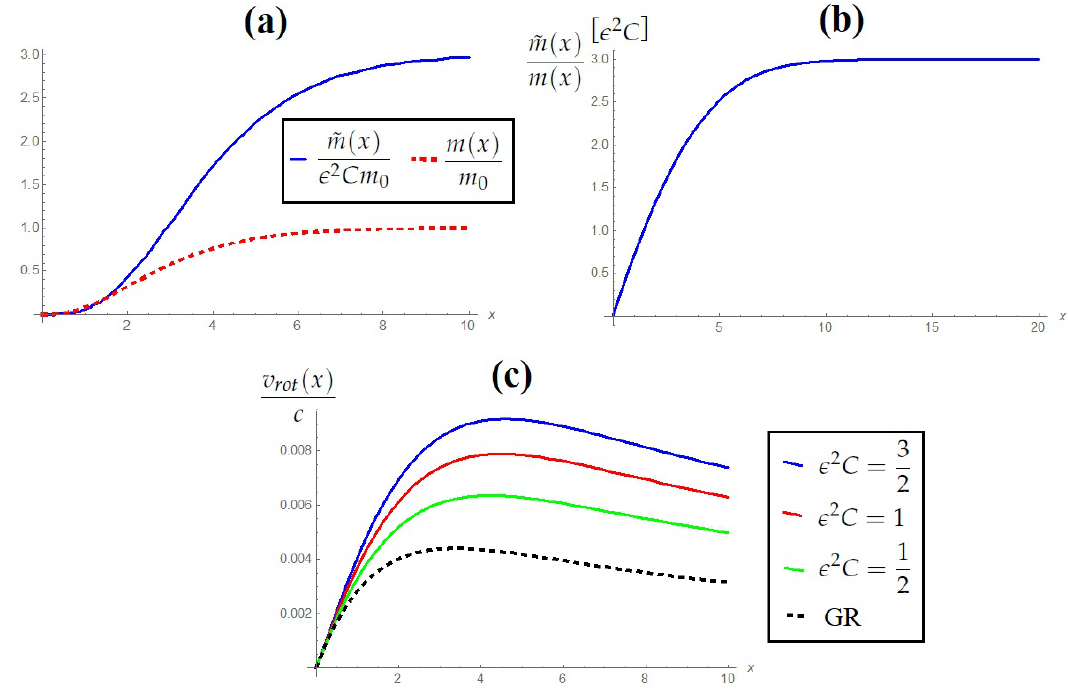
Figure 2. Exponential Profile Calculation. ( a ) ordinary and δ Matter vs. normalized radius, with m 0 = 8 π R 3 ρ 0 . From the center, more δ Matter is accumulated, but the behavior of both terms ( x ) become similar when we distance from the center; ( b ) ˜ m (in units of (cid:101) 2 C ) vs. normalized radius. m ( x ) ( x ) ∼ x , and, at the end of the We verify the last conclusion. In the center, the relation is almost linear, ˜ m m ( x ) ( x ) → 3 (cid:101) 2 C ; ( c ) rotation velocity vs. normalized radius for different values galaxy, it is like a constant, ˜ m m ( x ) of (cid:101) 2 C . The Black-Dashed line corresponds to GR case, so the (cid:101) 2 C value indicates the contribution of δ Matter. The similar behavior of both elements and the additional mass from δ Matter produce an amplifying effect in the rotation velocity. In these calculations, we have used κρ 0 R 2 = 10 − 4